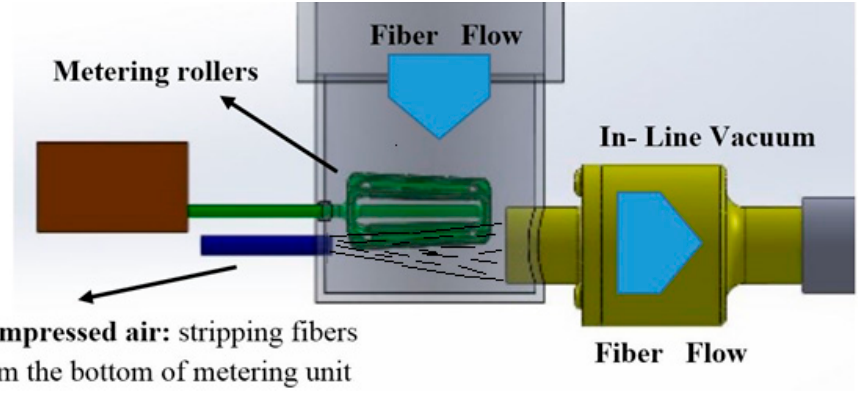
Figure 4. The schematic design of metering rollers, compressed air line and in-line vacuum.